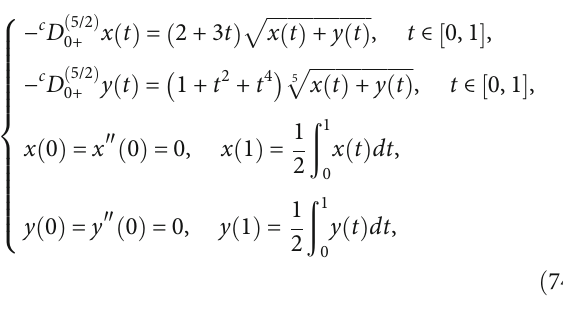
ffiffiffiffiffiffiffiffiffiffiffiffiffiffiffiffiffiffiffiffi